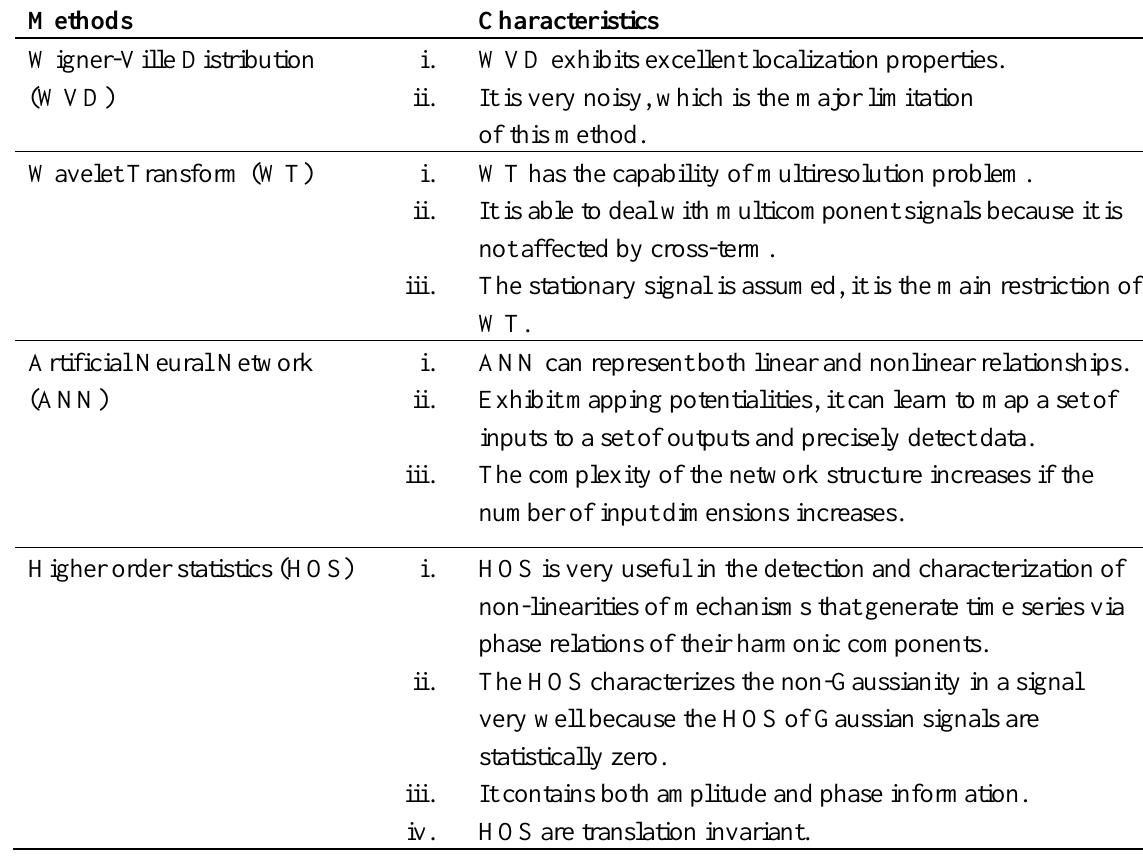
Table 10. Summary of most important